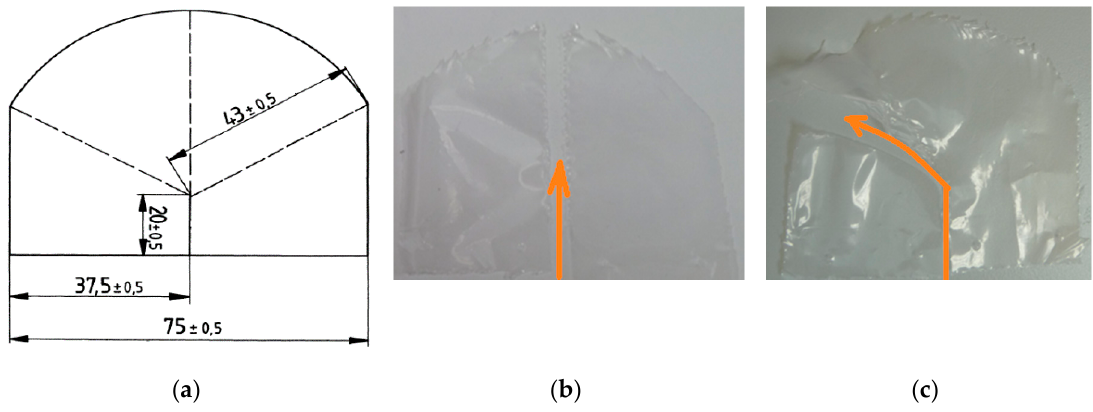
Figure 10. Test Specimen according to the Standard DIN EN ISO 6383-2: 2004 [20] ( a ): Crack course in MD, ( b ): straight crack, ( c ): curved cracks.